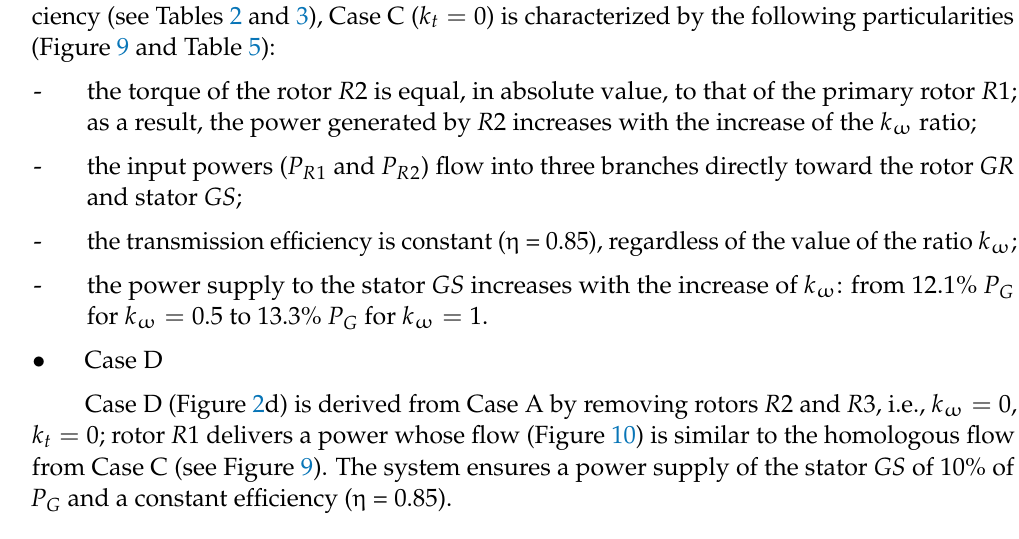
10% of P G and a constant efficiency ( η = 0.85).